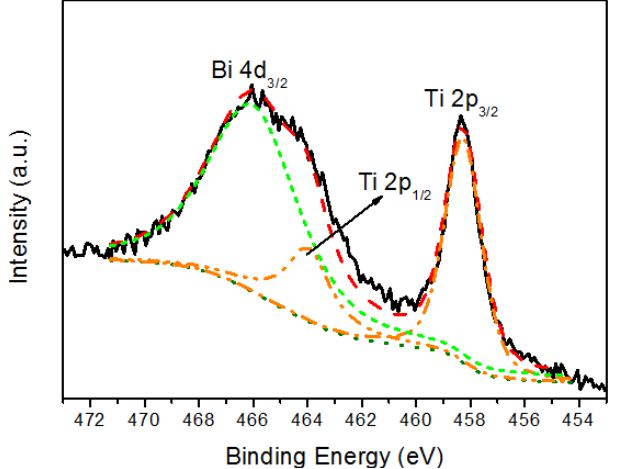
Figure 4. Ti 2p XPS spectrum recorded from the coating.